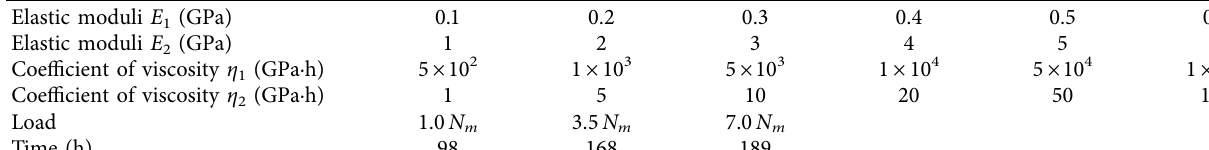
Table 4: Summary of the parameters used for sensitivity of strain.